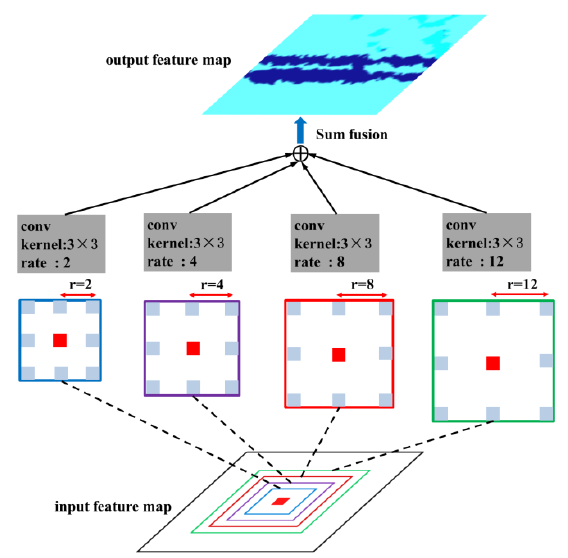
Figure 7. Illustration of multi-scale processing.